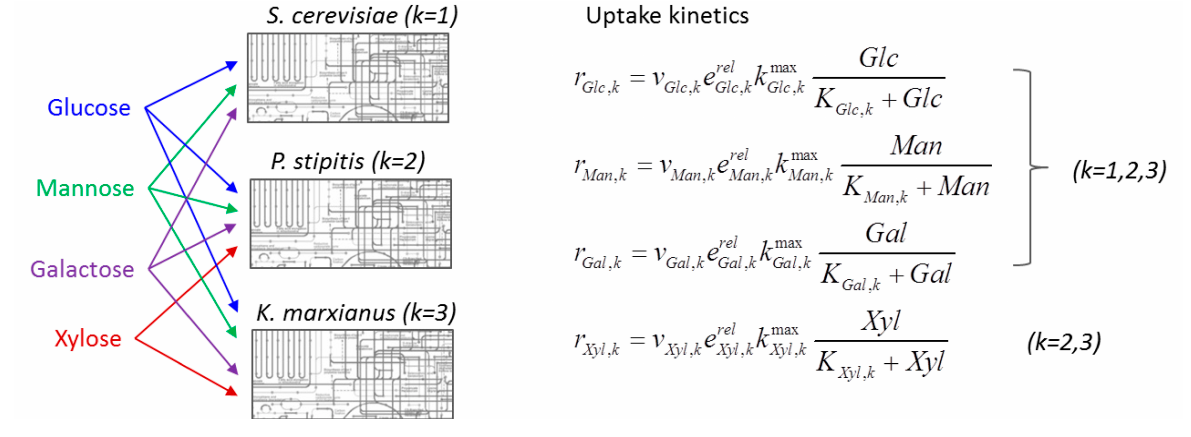
Figure 12. Uptake kinetics for the hybrid cybernetic model (HCM) simulation of the consortia composed of three yeast strains ( Saccharomyces cerevisiae , Pichia stipitis , and Kluyveromyces marxianus ) growing on four different carbon sources. Glc , Man , Gal , and Xyl denote the concentrations of glucose, mannose, galactose, and xylose, respectively. The symbols e and v represent enzyme level and its activity. For the sake of simplicity, self-substrate inhibition term is neglected.